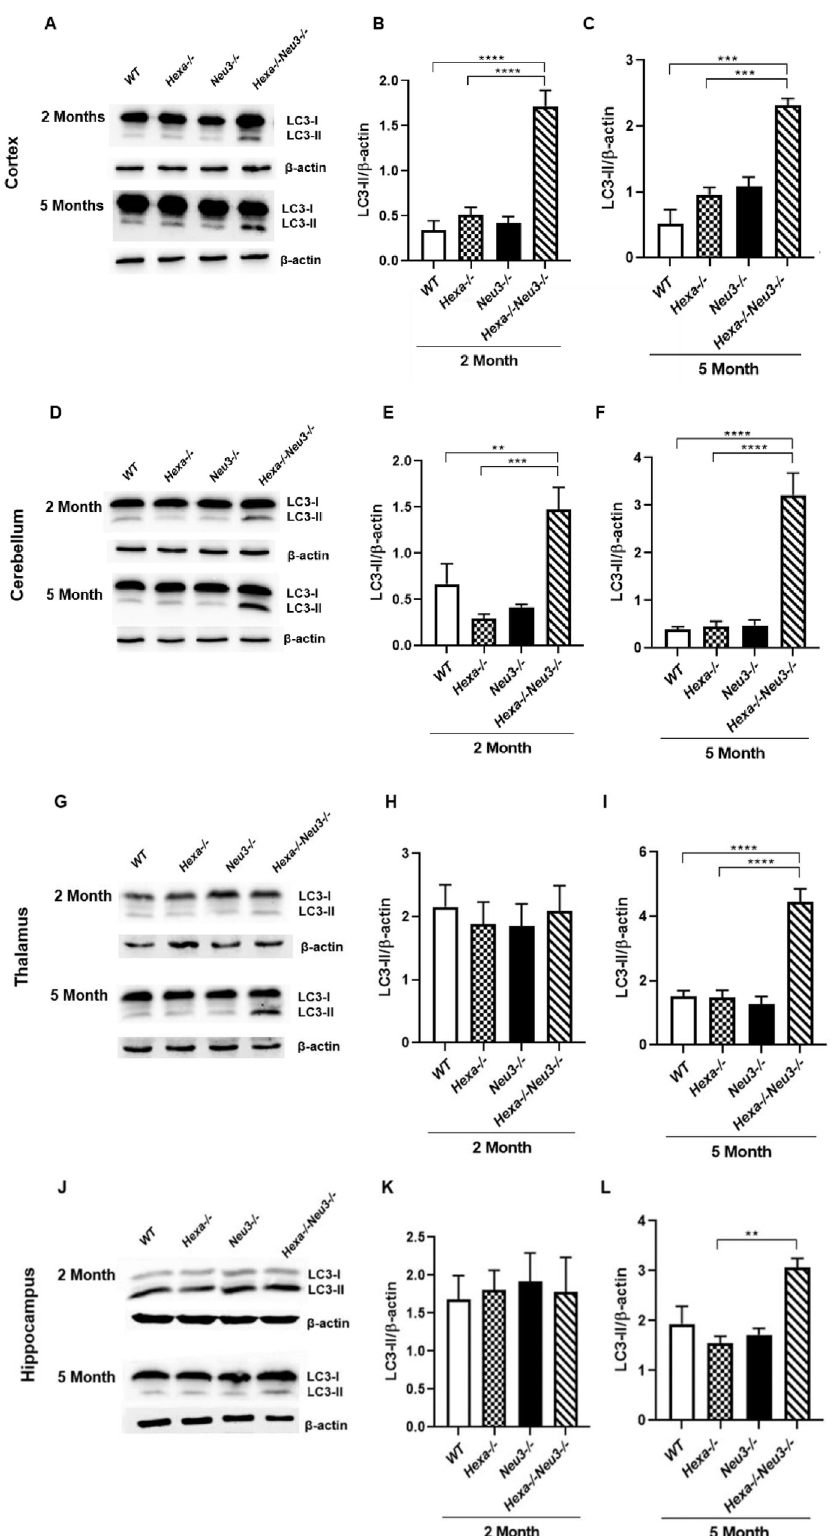
Fig 4. Immunoblot images and densitometric analysis of the nti-LC3 in the cortex (A-C), cerebellum (D-F), thalamus (G-I), and hippocampus (J-L) of 2- and 5-month-old WT , Hexa-/- , Neu3-/- , Hexa-/-Neu3-/- mice. β -actin was